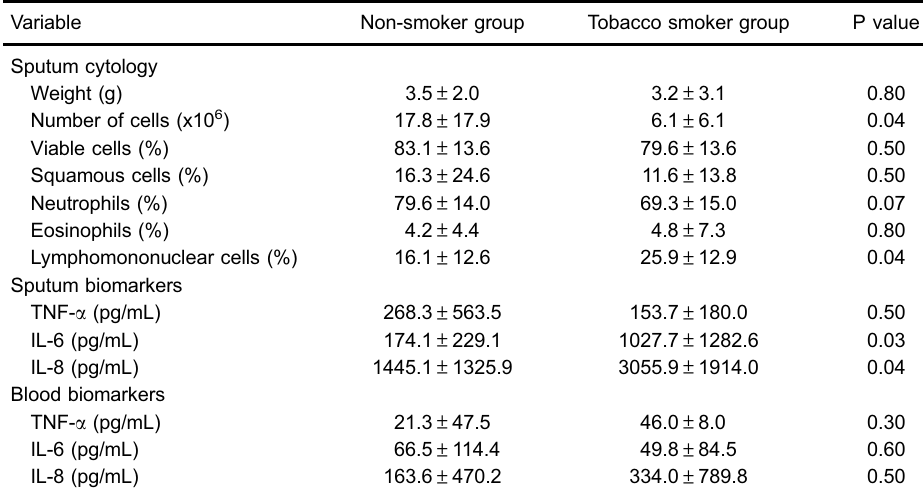
Table 4. In fl ammatory biomarkers according to chronic obstructive pulmonary disease groups.